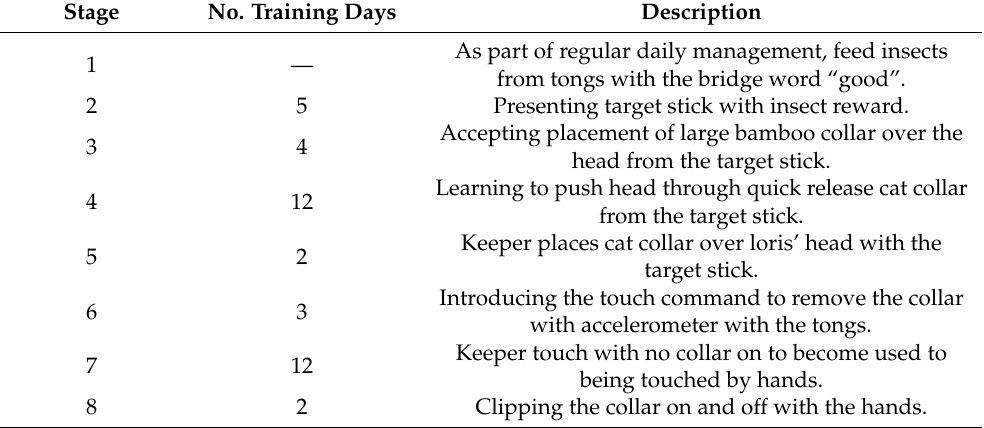
Table 1. Description and duration of the seven stages of positive reinforcement and target training of a Bengal slow loris to wear a collar with an attached accelerometer from 29 October 2019 to